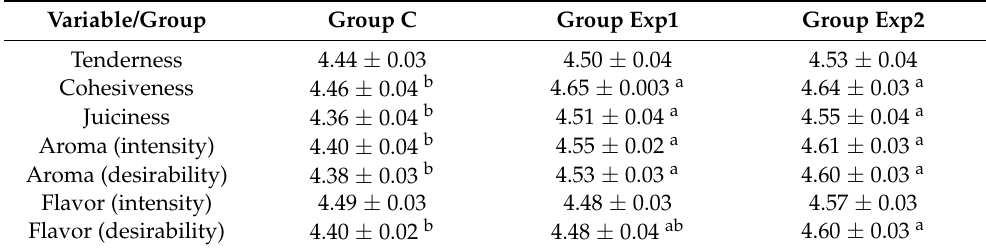
Table 6. Sensory characteristics of pectoralis major muscles in organic turkeys receiving three different diets.